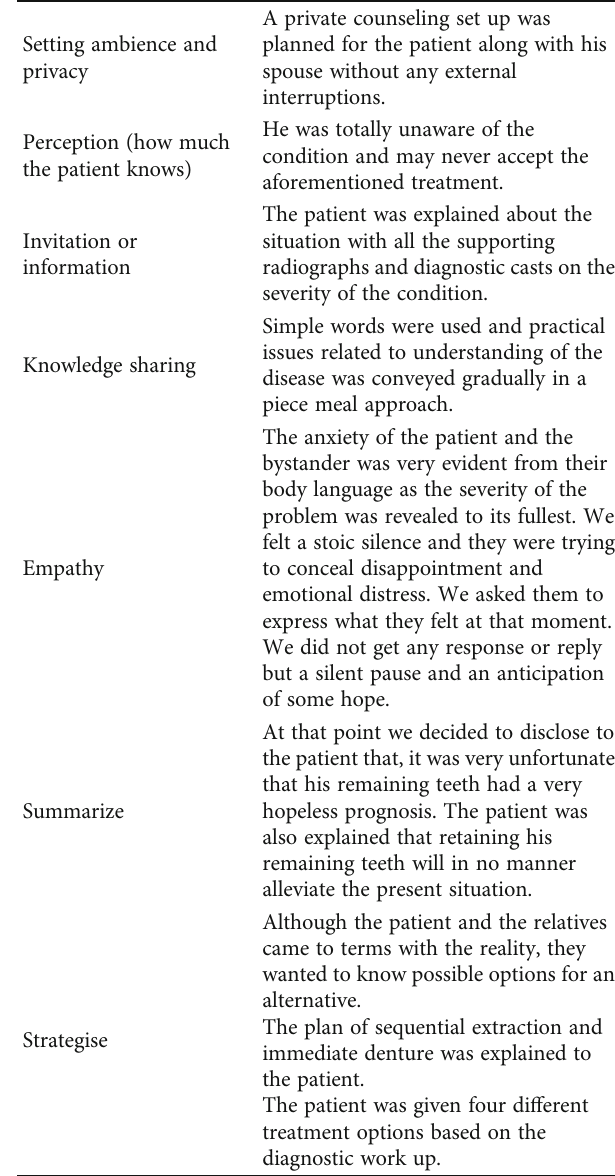
Table 1: The SPIKES